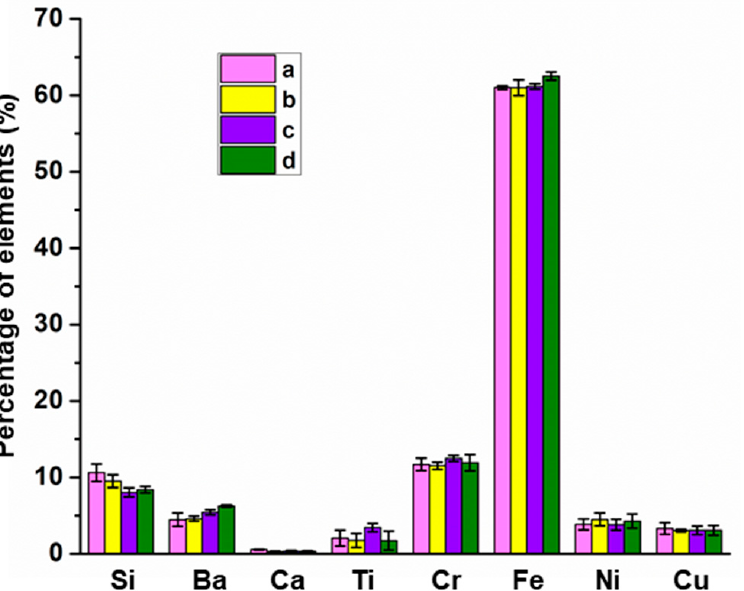
Figure 2. Bulk chemical characterisation of a—OB, b—OB-POX, c—OB-POX/L-Trp, d—OB-POX/D-Trp using XRF.